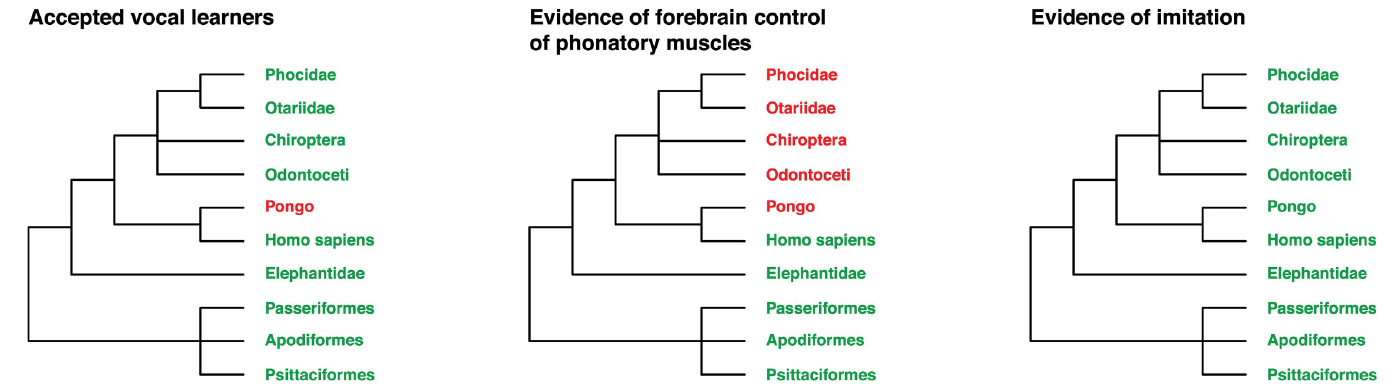
Fig 2. Comparison of simplified phylogenies of vocal learning: The canonical list with the addition of the orangutan ( Pongo ) for contrast. Key: green indicates species or orders considered to conform to the criterion on each tree, and red indicates species or orders that are considered not to. Left: list of accepted vocal learners. Center: list of species for which there is evidence of a direct connection between forebrain and phonatory muscles. Right: list of species for which there is (some) evidence of vocal imitation.